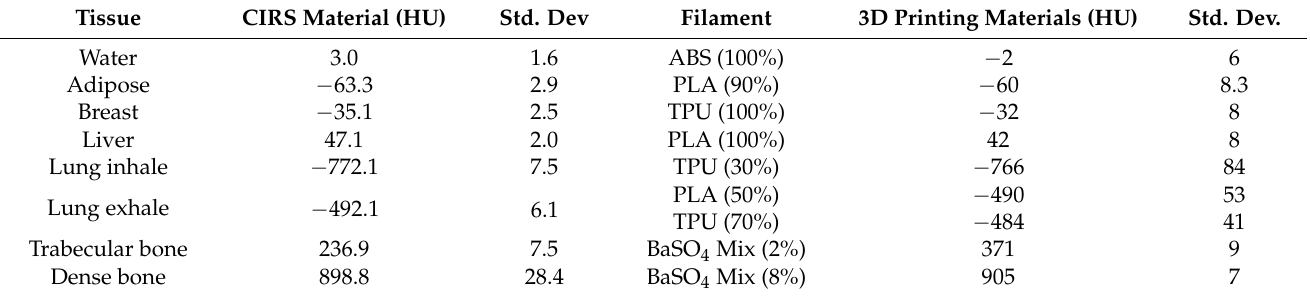
Table 3. Comparison of CIRS phantom tissue equivalent materials and 3D printing